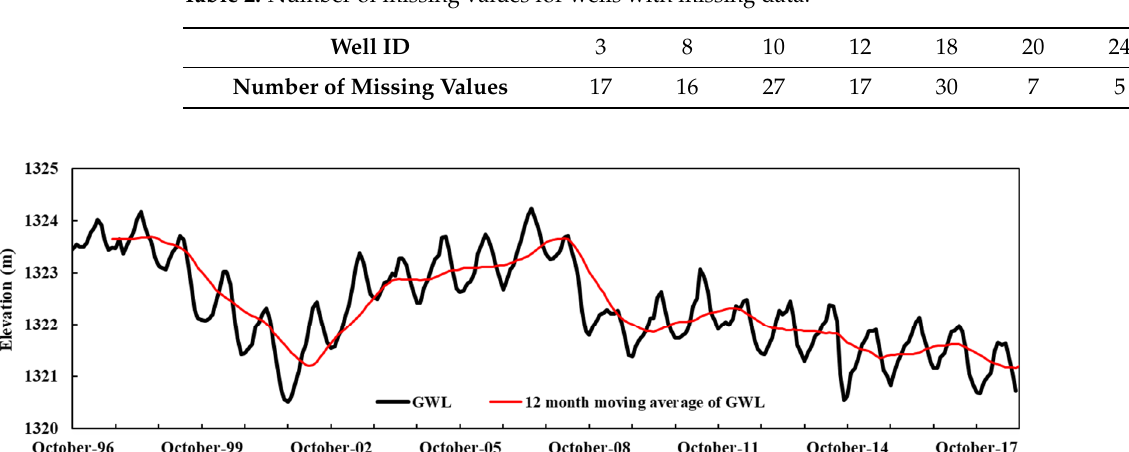
Figure 2. Borehole locations with Thiessen polygons.